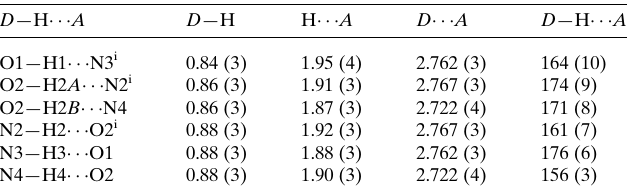
Table 1 Hydrogen-bond geometry (A˚ , (cid:5) ).